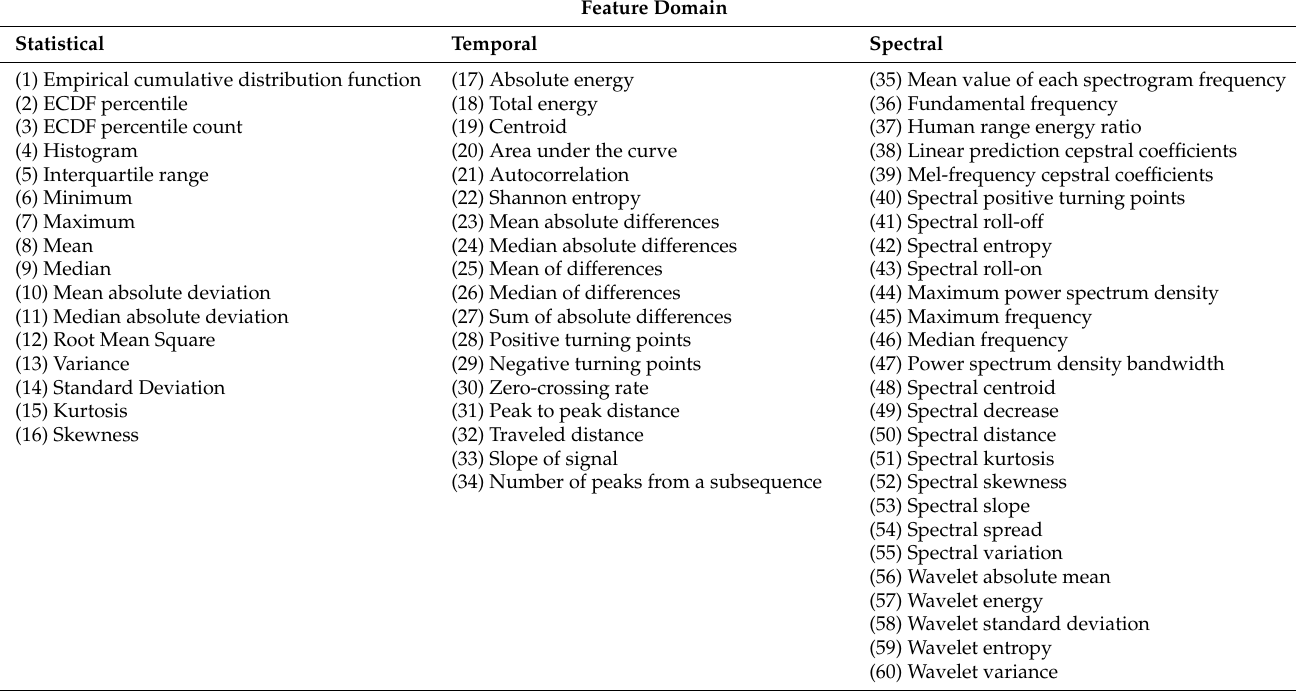
Table 2. A summary list of the extracted features used in this